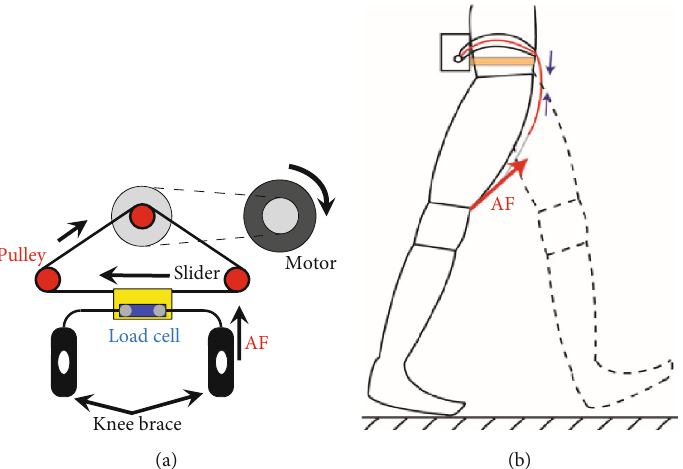
Figure 3: Illustration of the actuation mechanism. (a) When the motor rotates, the slider moves through the pulley system and provides assistive forces for hip fl exion by pulling the straddle cables of the knee braces and slacking the straddle cable of the other knee brace. The motor rotates reversely for providing hip fl exion assistance to the other leg. (b) During the preswing phase, the assistive force is applied at one knee brace because the motor pulls a straddle cable.